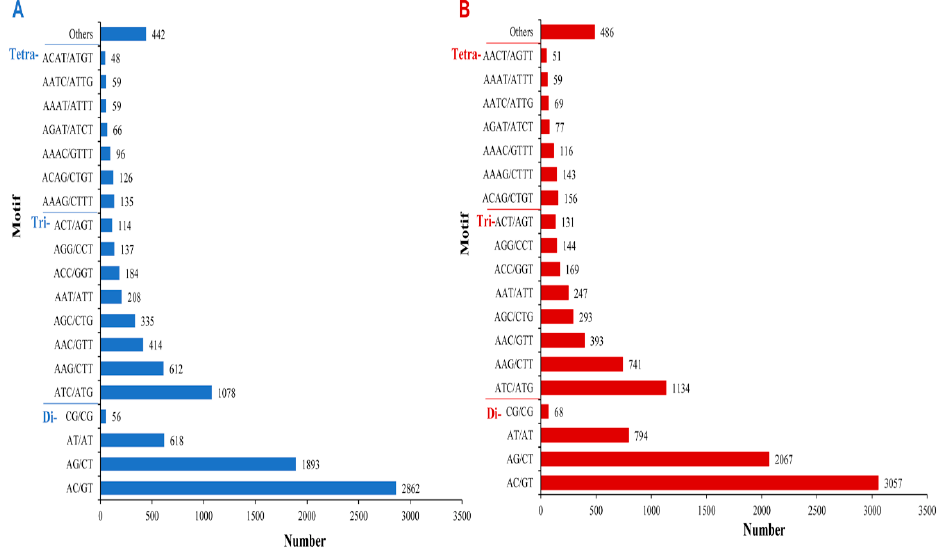
Figure 12. Frequency distribution of SSR repeat types in A. chejuensis ( A ); and A. quelpartensis ( B ) transcriptome.